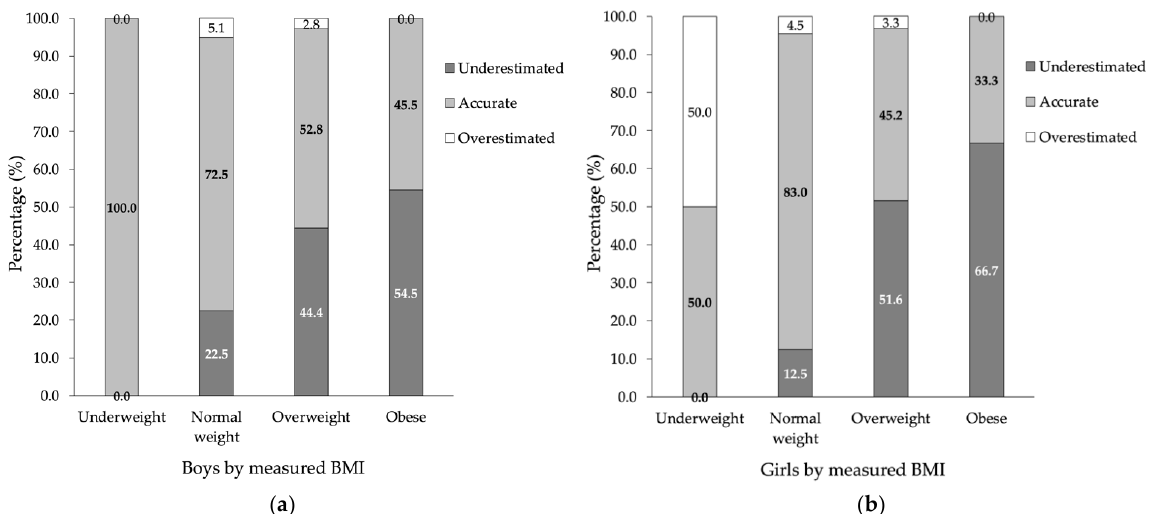
Figure 3. Comparison between measured BMI and parental perception of children’s body weight. ( a ) Accuracy of parental perception of children’s body weight by measured BMI in boys; ( b ) Accuracy of parental perception of children’s body weight by measured BMI in girls.